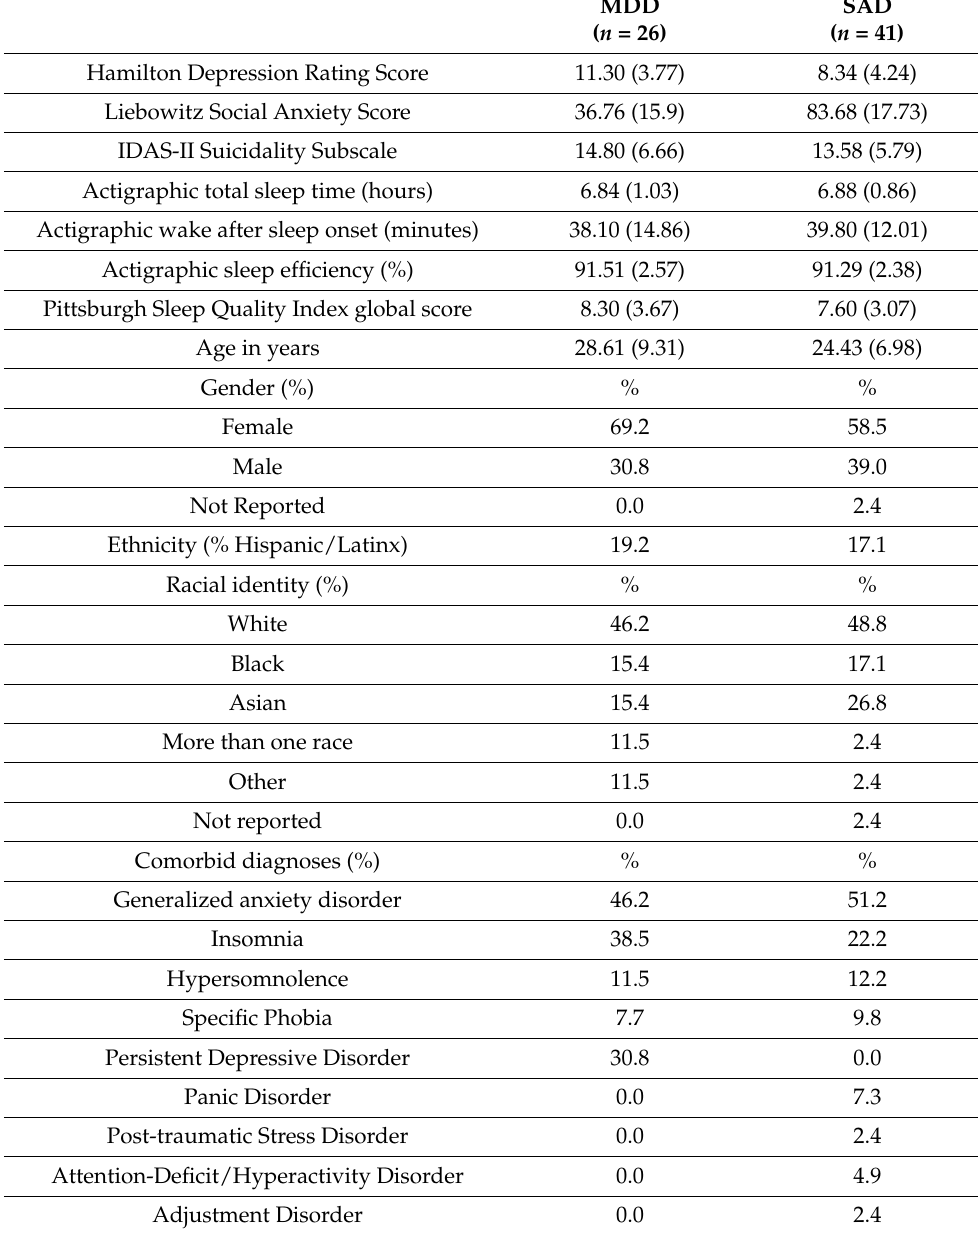
Table 1. Clinical, sleep, and demographic characteristics for diagnostic groups: Values reflect the mean, and standard devations are in